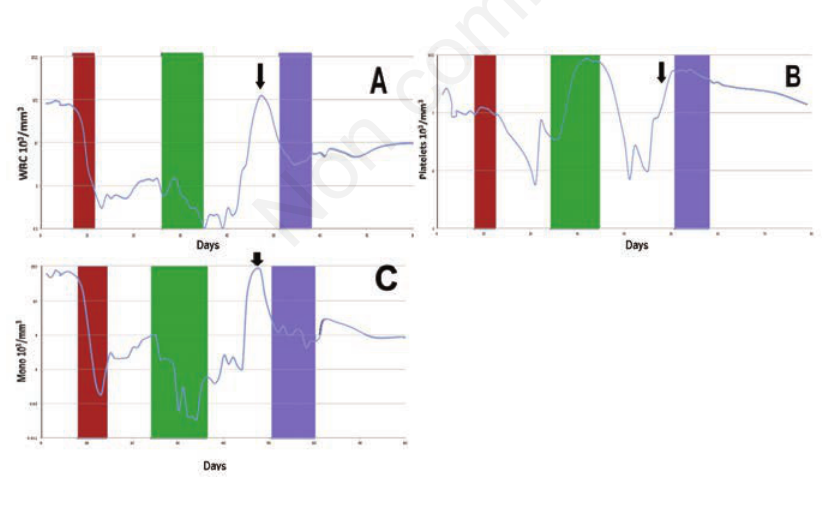
Figure 1. Response of white blood cell (WBC), platelets, and monocytes to chemothera- py with only azacitidine inducing sustainable remission in the first 80 days. The first induction (red box) included fludarabine and cytarabine, and the second induction (green box) included daunorubicin and cytarabine. The WBC normalized only after hydroxyurea (arrow) and the first cycle of azacitidine (blue box) (A). Platelets rose markedly after a brief nadir following the second induction therapy, and only normalized after azacitidine therapy (B). Monocytes (including monoblasts and promonocytes) rebounded following the first two cycles of induction therapy and only normalized after azacitidine therapy